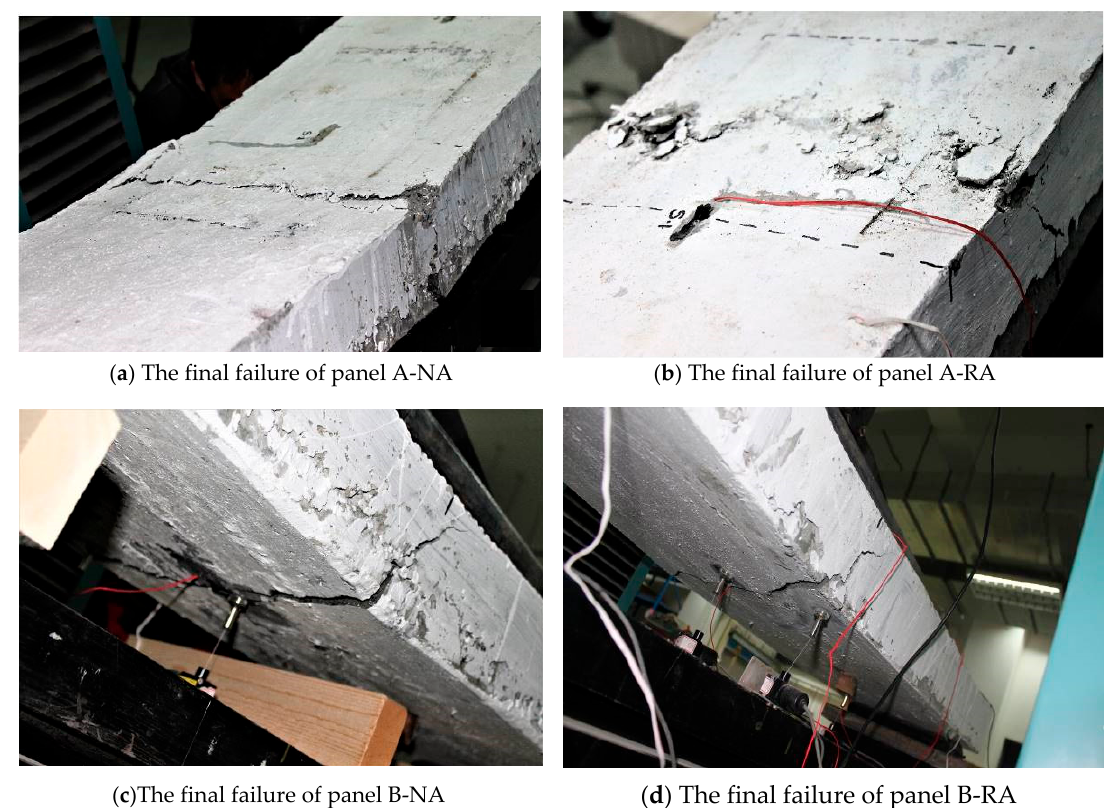
Figure 10. Failure patterns of composite deck